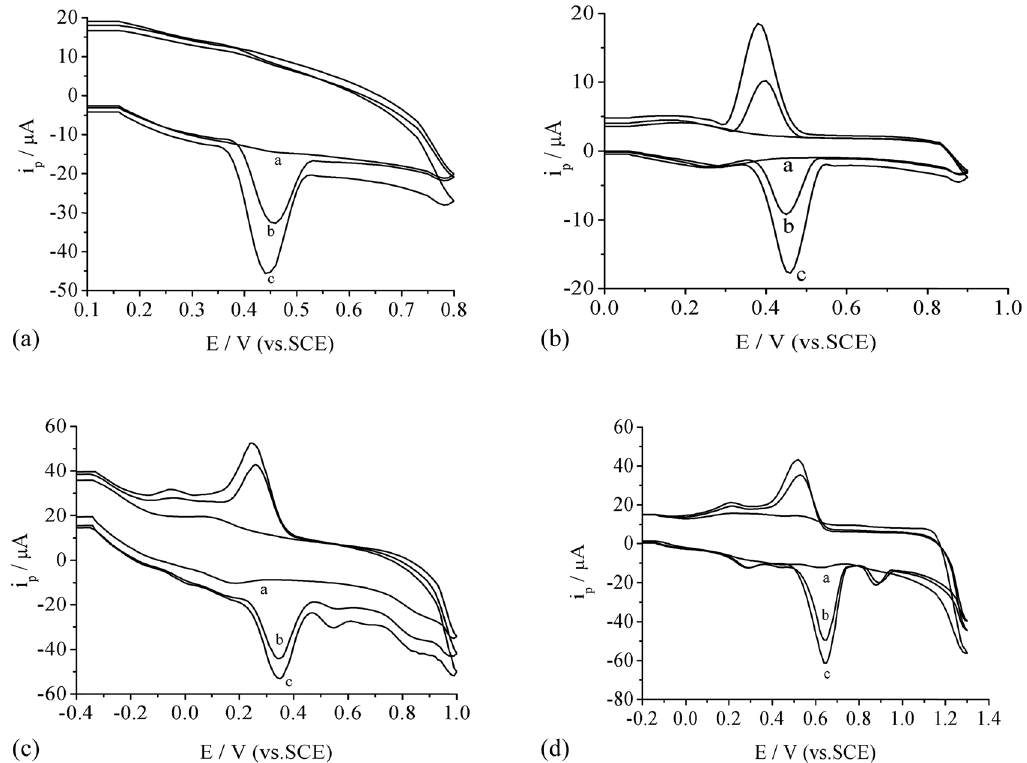
Figure 1: The CV curve of four polyphenolic compounds on the MWCNTs/GE. ( a (( a ) Na 2 HPO 4 – C 6 H 8 O 7 , ( b ) Na 2 HPO 4 – C 6 H 8 O 7 + 3 mg/L of GA, ( c ) Na – C + 5 mg/L of GA )) ; ( b (( a ) HAc – NaAc, ( b ) HAc – NaAc + 0.5 mg/L of CA, ( c ) HAc – NaAc + 1 mg/L of CA )) ; ( c (( a ) 2 HPO 4 6 H 8 O 7 C 6 H 8 O 7 – Na 3 C 6 H 5 O 7 , ( b ) C 6 H 8 O 7 – Na 3 C 6 H 5 O 7 + 6 mg/L of FA, ( c ) C 6 H 8 O 7 – Na 3 C 6 H 5 O 7 + 10 mg/L of FA )) ; and ( d (( a ) KCl, ( b ) KCl + 10 mg/L of VA, ( c ) KCl + 15 mg/L of VA ))